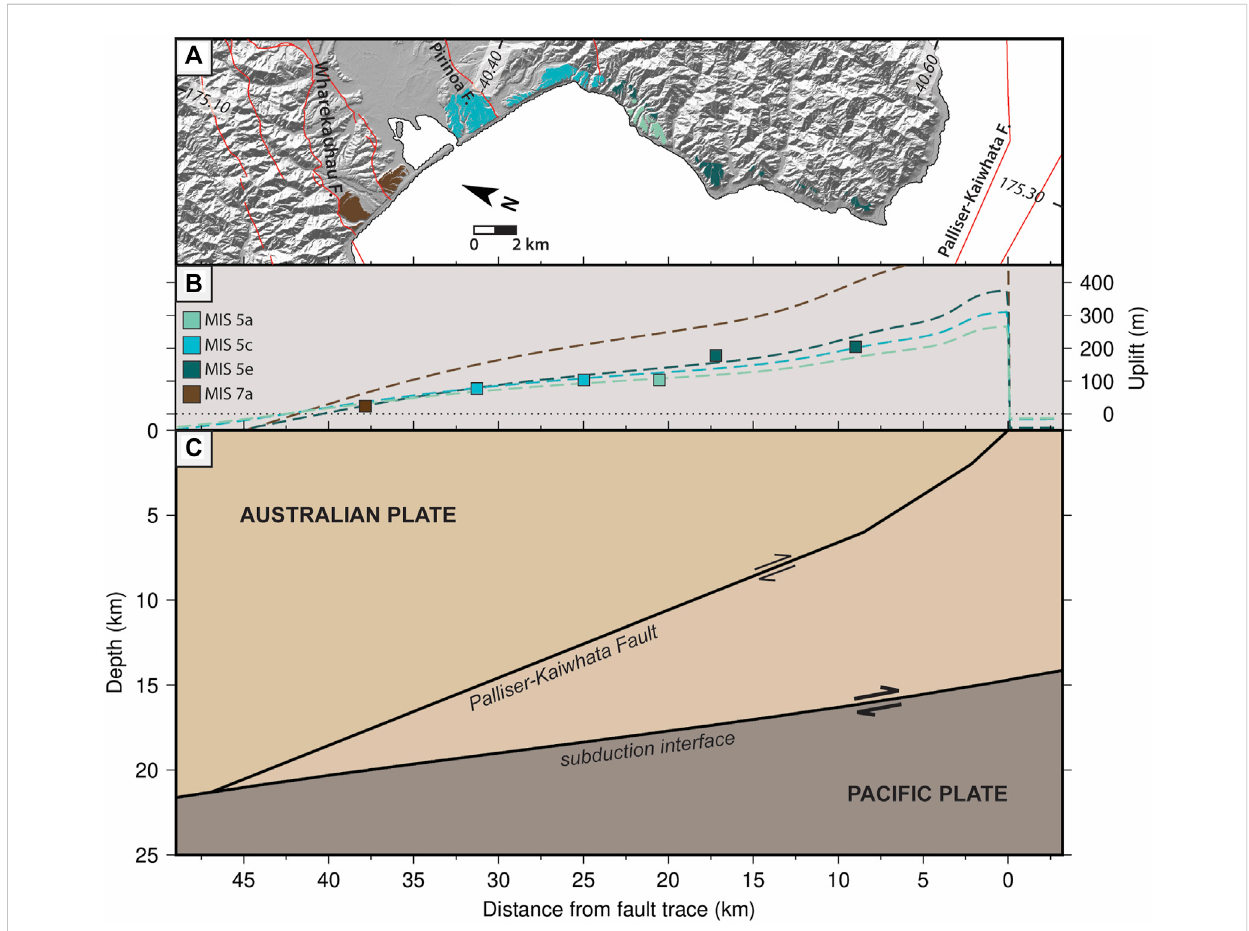
FIGURE 7 Dislocation modelling results of uplift from 5.3 mm/yr of dip-slip motion on the Palliser-Kaiwhata Fault with a listric geometry and assuming a T e of 40 km(Model 1inTable 3).Thismodelled fault dips40 ° NWbetween thesurfaceand2 kmvertical depth, 30 ° NWbetween 2 kmand 6 kmdepth, and20 ° NW between 6 kmdepth and 23 km. (A) Hillshaded topography, major onshore and offshore fault zones and mapped marine terrace treads (coloured by terrace age) in the area of our modelled pro fi le. (B) Modelled and observed uplift along the pro fi le. Dashed lines show modelled uplift and coloured squares show observed uplift; both modelled and observed uplift are colour-coded by age. (C) Modelled fault geometry and depth to the Hikurangi Subduction interface along our pro fi